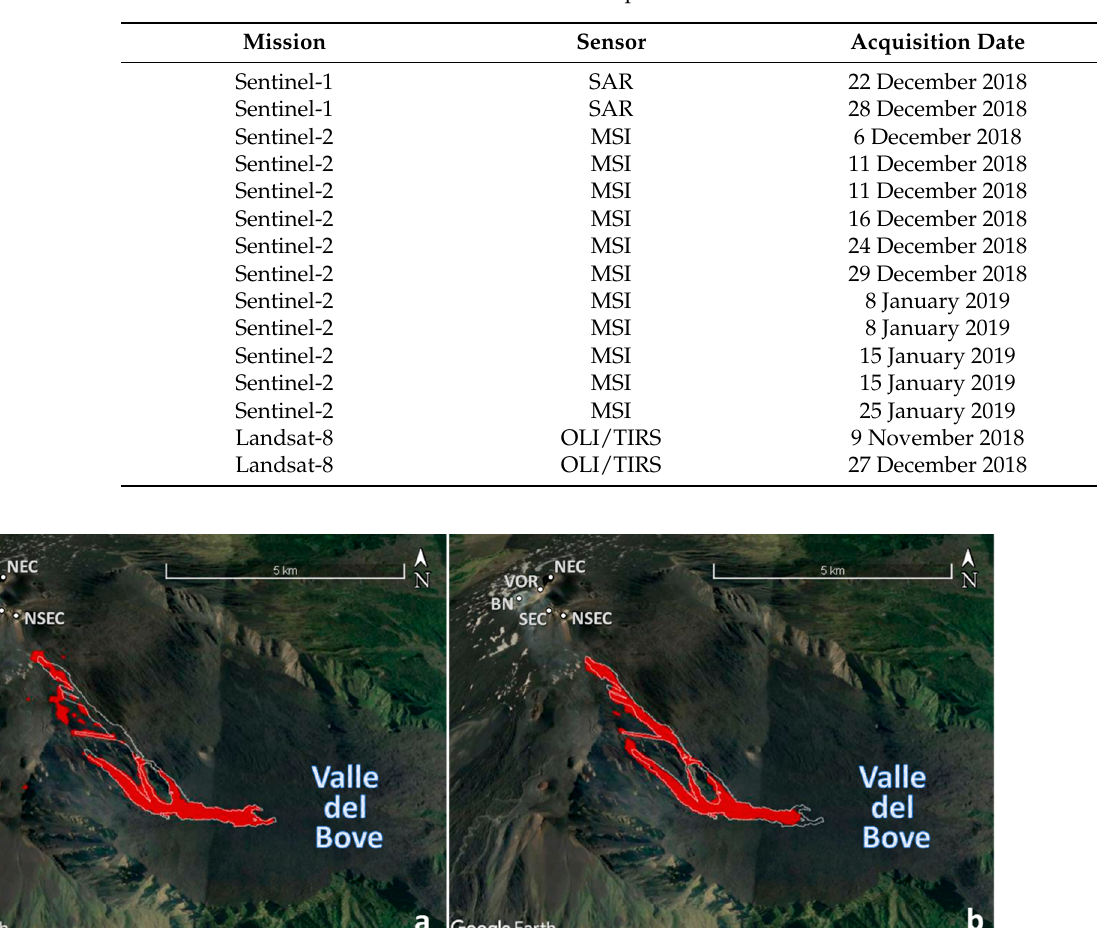
Table 2. Satellite dataset used for the 2018 Etna eruption.